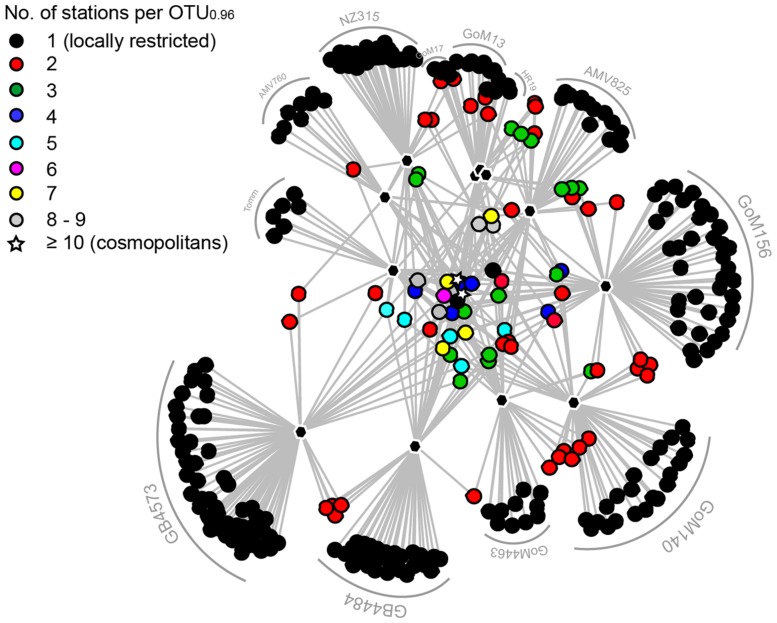
Network graph displaying the connectivity among sampling sites based on presence-absence of MasD OTU0.96. The different colors indicate the number of investigated seeps that contained an individual OTU. Black dots are locally restricted OTU0.96, the stars are cosmopolitan OTU0.96. OTU are connected to the sampling sites (black polygons) they occur at.